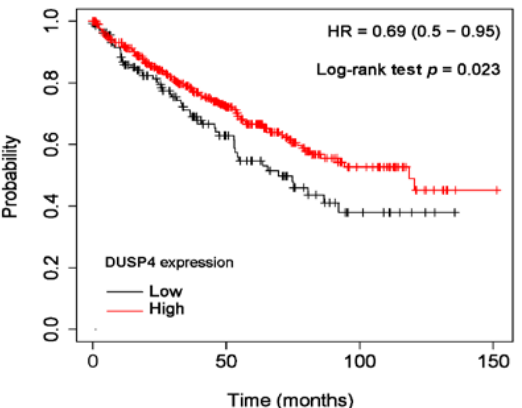
Figure 3. Survival analyses using the Kaplan-Meier method for ccRCC. ( a ) Cancer-specific survival (Log-rank test, p = 0.010). ( b ) Recurrence-free survival (Log-rank test, p = 0.007).